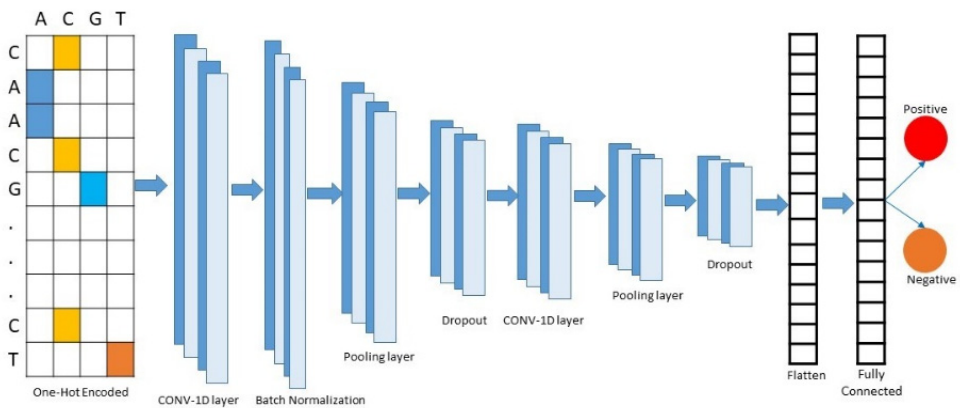
Figure 3. Model architecture. Figure 3. Model